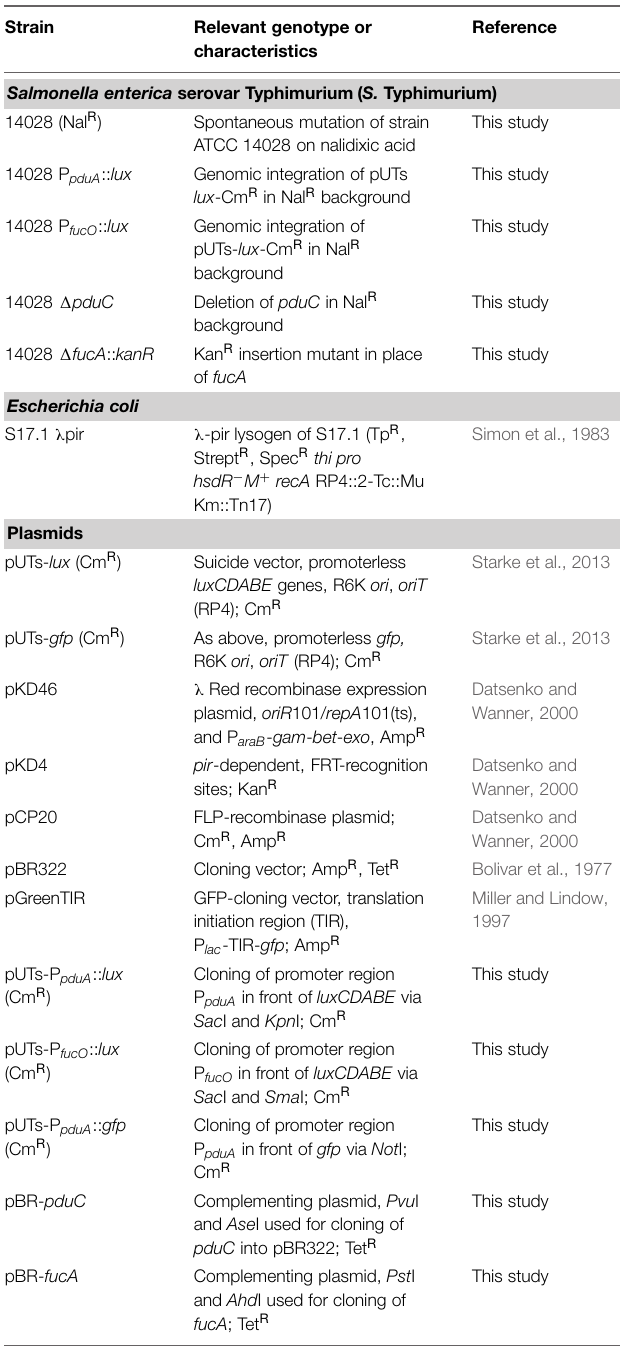
TABLE 1 | Strains and plasmids used in the